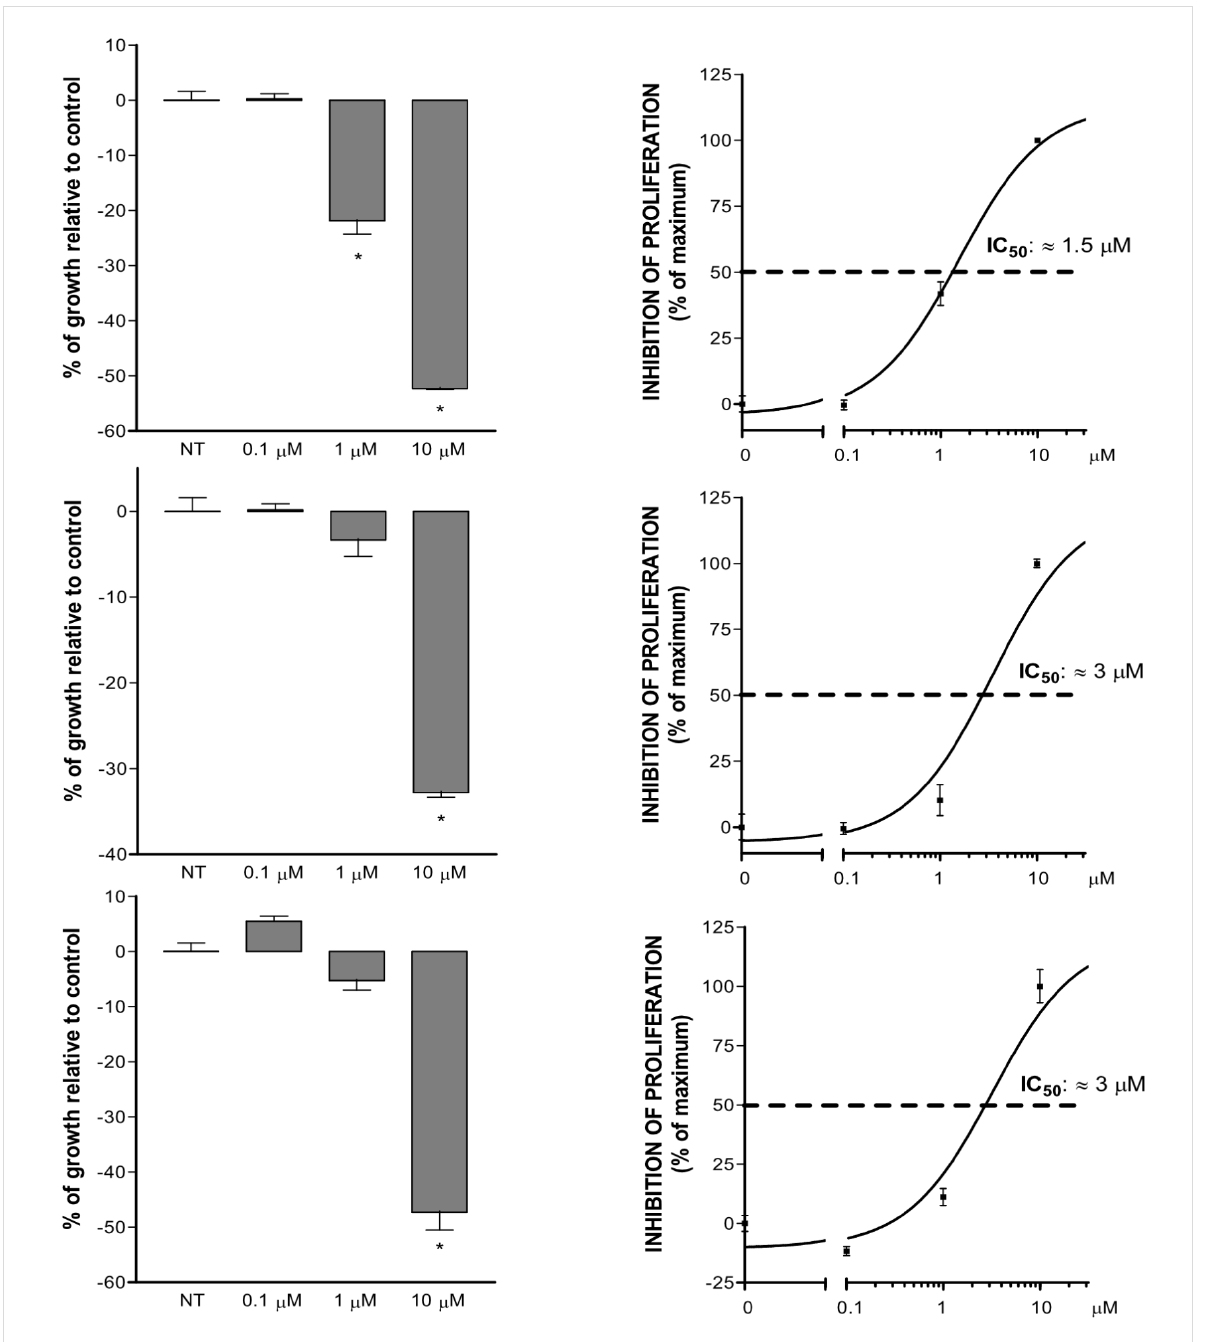
Figure 4: Antiproliferative activity of theonellapeptolides 1 – 3 on hepatic carcinoma cell line. The MTT assay was performed on HepG2 cells treated with increasing doses for 48 hours. Left panel: Proliferation rate expressed as Δ % of absorbance compared to untreated cells. The values are expressed as the mean ± standard error. Right panel: Computation of IC 50 values. From top to bottom: Theonellapeptolide Id, sulfinyltheonellapep- tolide and theonellapeptolide If (* p < 0.05 compared to untreated cells; n = 4).